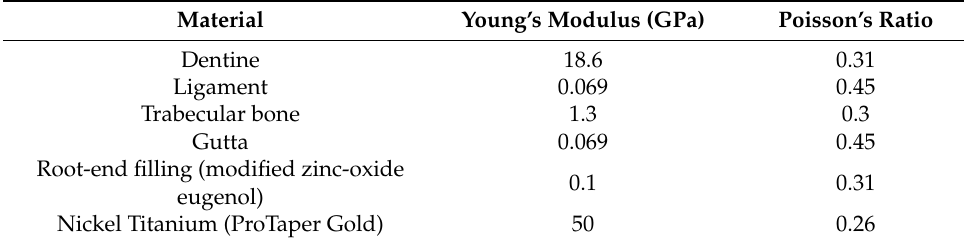
Table 1. Material properties